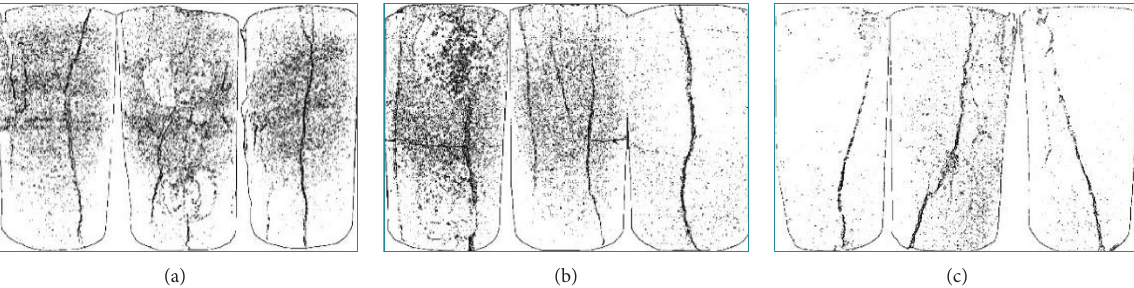
Figure 7: Macroscopic failure characteristics of the WCST specimens under different numbers of dry-wet cycles. (a) N � 0. (b) N � 5. (c) N �